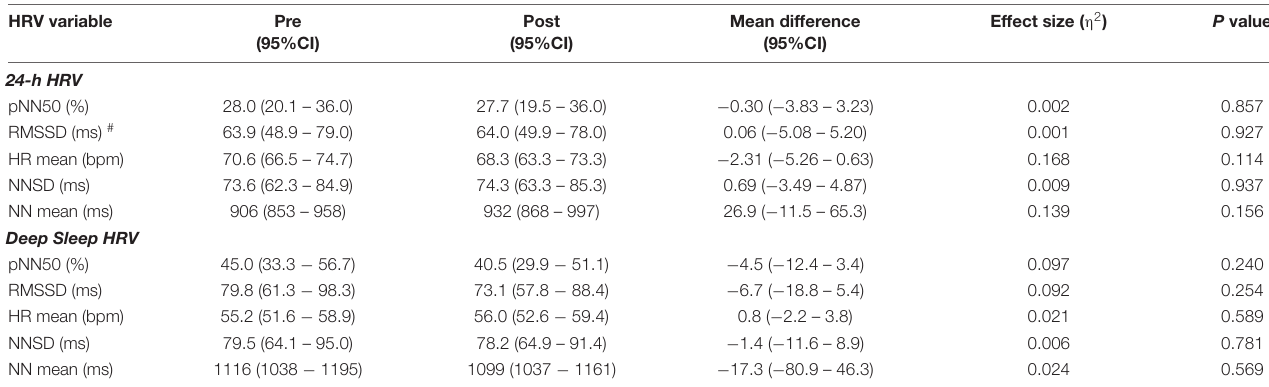
TABLE 1 | Time domain HRV characteristics calculated pre and post high-volume endurance exercise ( n =